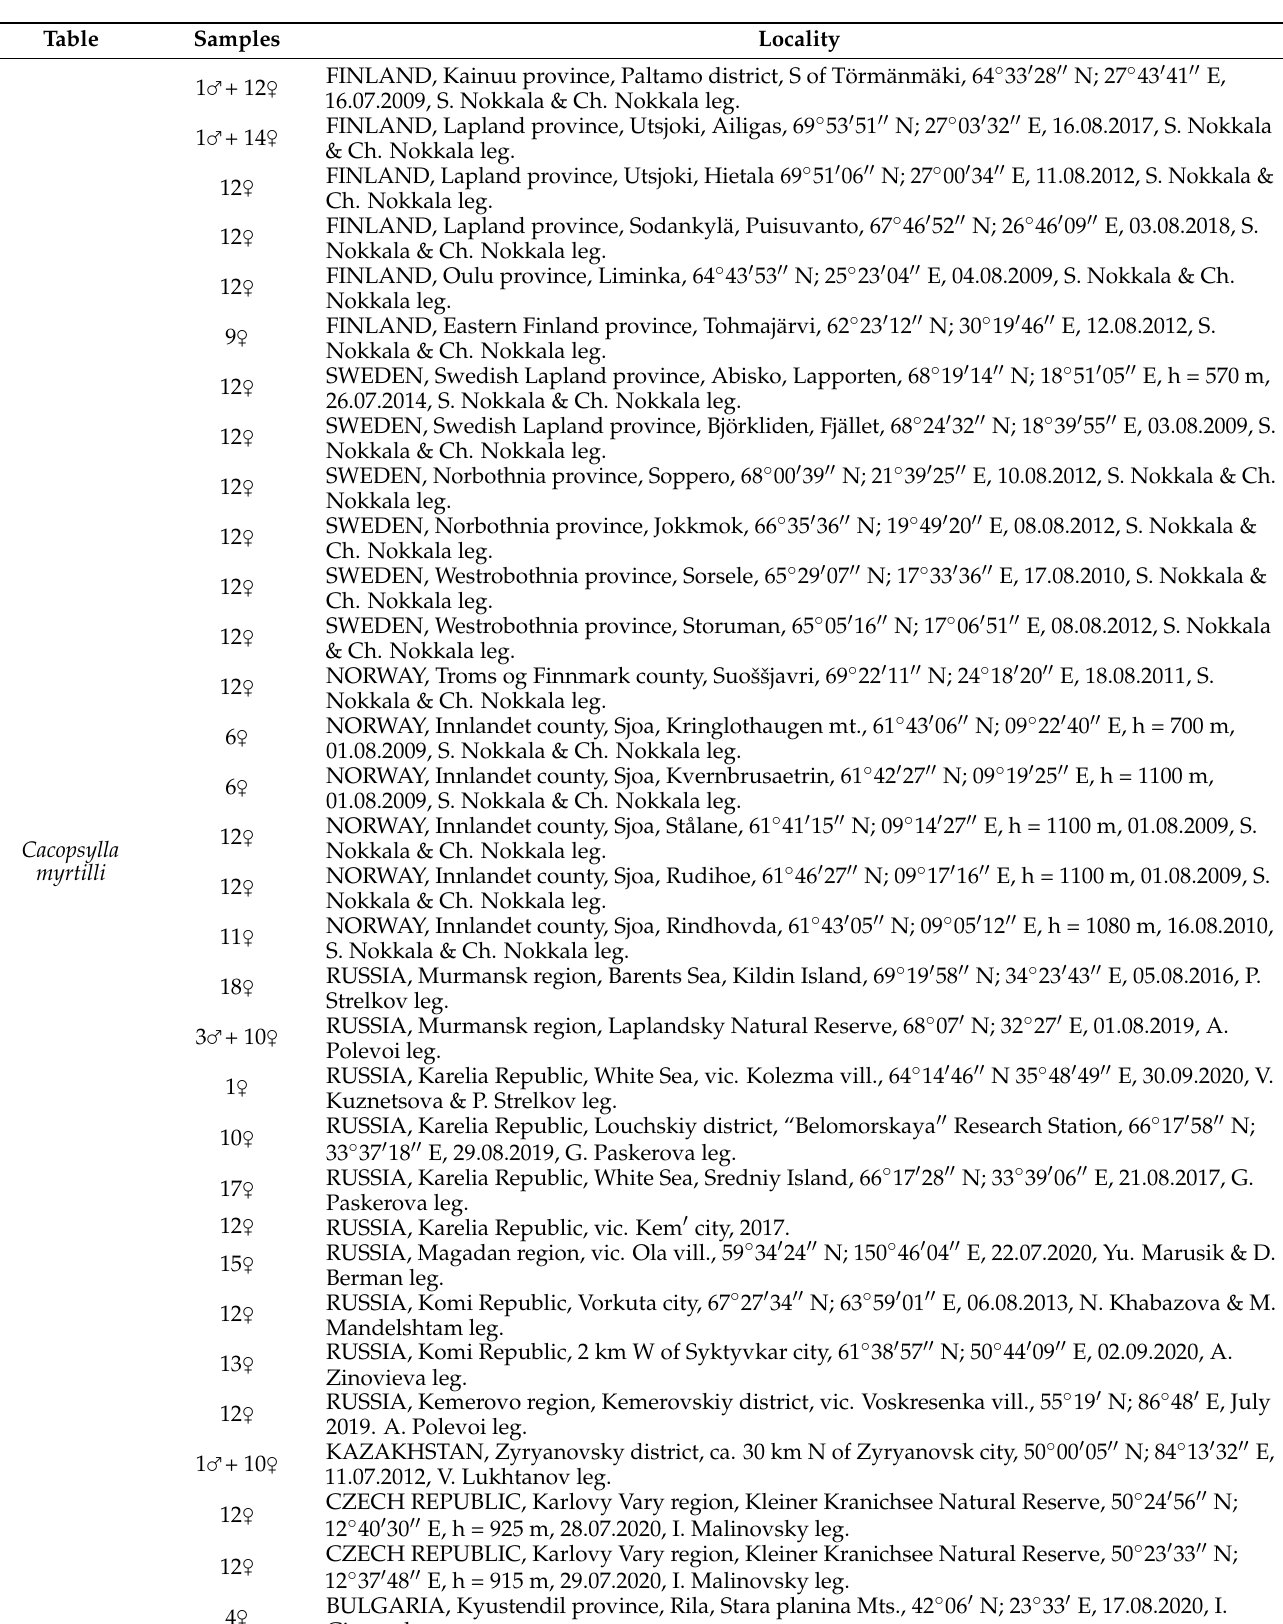
Samples Locality